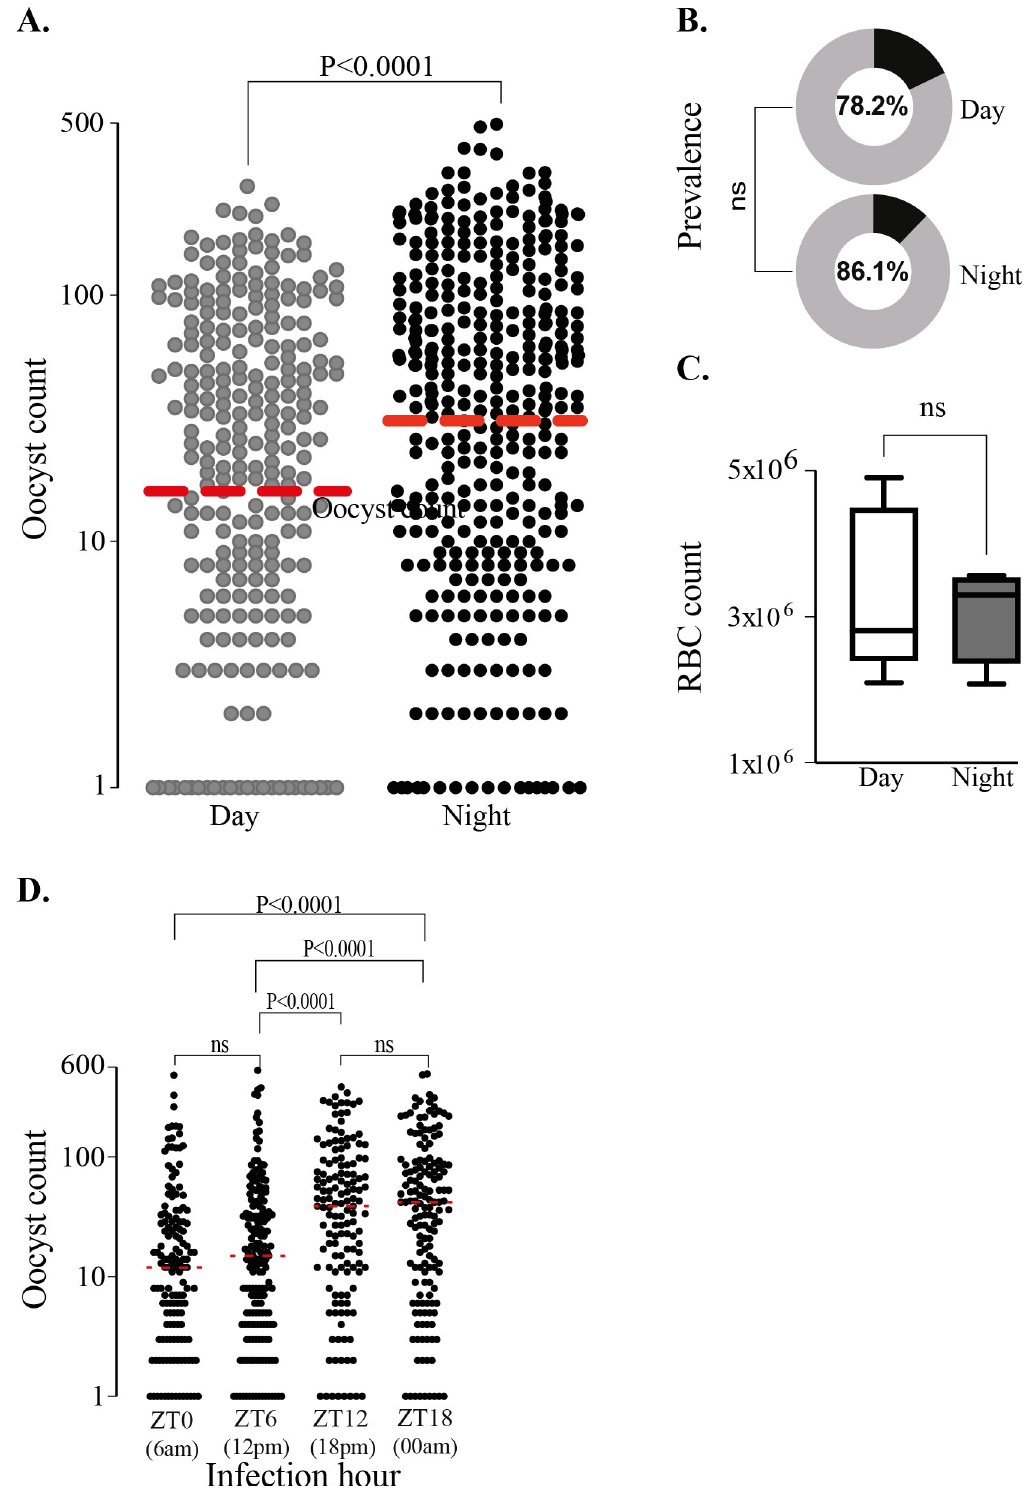
Fig 1. Plasmodium infectivity at day-time vs night time. ( A ) Oocyst intensity in mosquitoes received bloodmeal containing gametocyte from same culture flask at day-time (7 ZT) vs night-time (14 ZT); ( B ) Oocyst infection prevalence in day-time and night-time. The data in A&C were from five replicates while B were from two replicates. Midguts dissection for oocyst